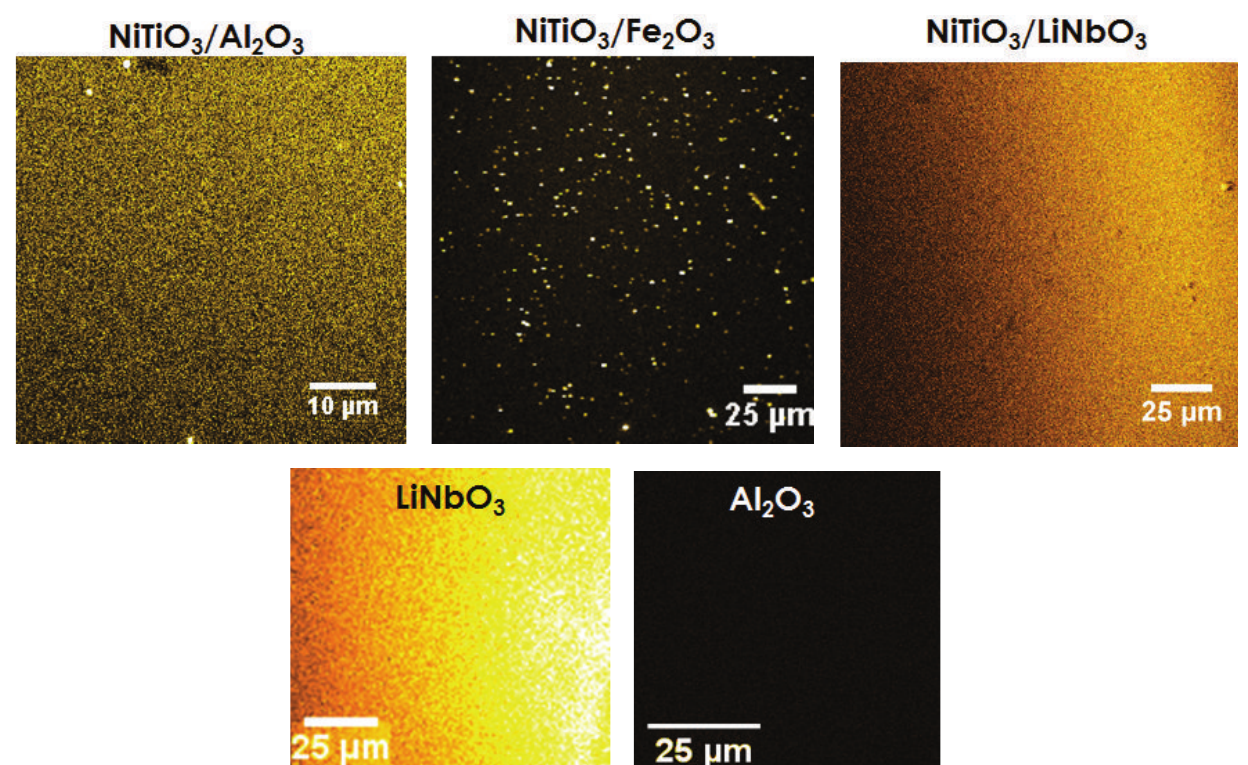
Figure 5: (Color online) Optical SHG images of NiTiO 3 /Al 2 O 3 , NiTiO 3 /Fe 2 O 3 , and NiTiO 3 /LiNbO 3 films of similar thicknesses. Images for strongly ferroelectric single crystalline LiNbO 3 and nonpolar Al 2 O 3 are shown as